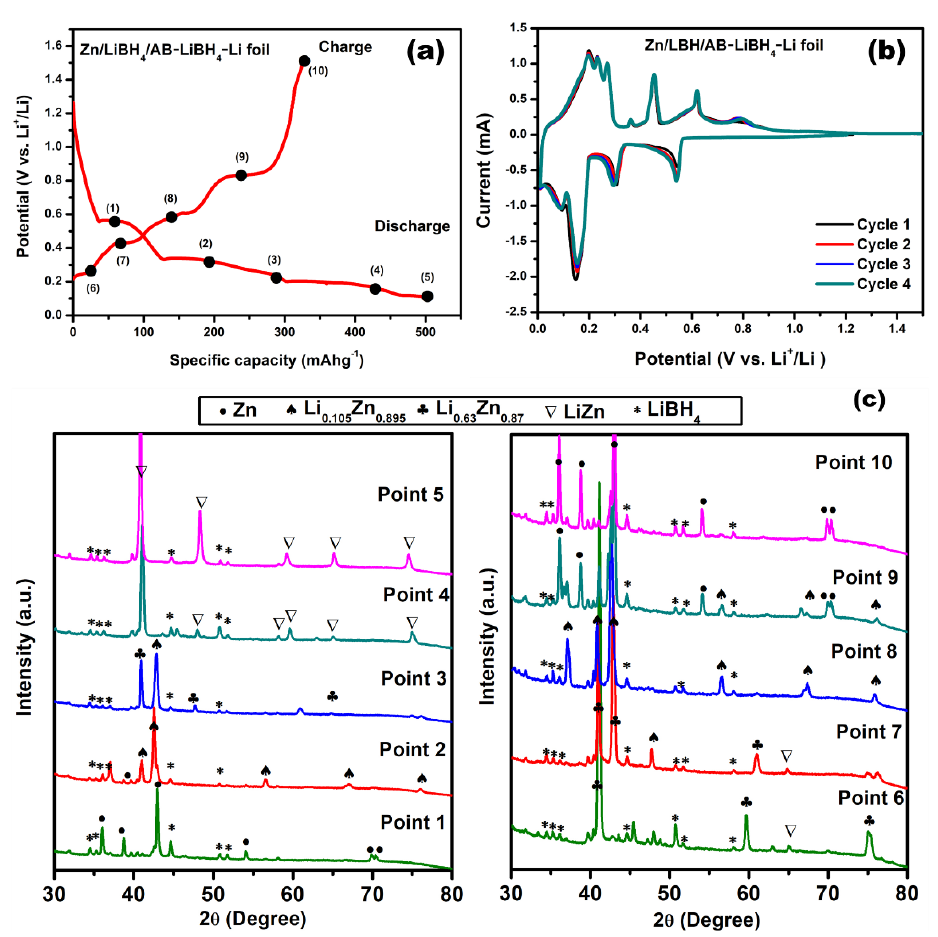
Figure 2. ( a ) First galvanostatic discharge – charge profile for Zn − LiBH 4 − AB/LiBH 4 /Li foil coin cell; ( b ) cyclic voltammetry curves; ( c ) X-ray diffraction profiles of the Zn − LiBH 4 − AB/LiBH 4 /Li foil coin cell at different charge–discharge potentials of first electrochemical discharge–charge process. The JCPDS numbers corresponding to different phases are Zn (00-087-0713), Li 0.105 Zn 0.895 (00-002-7089), Li 0.63 Zn 0.87 (00-008-1460), LiZn (00-000-8410), and LiBH 4